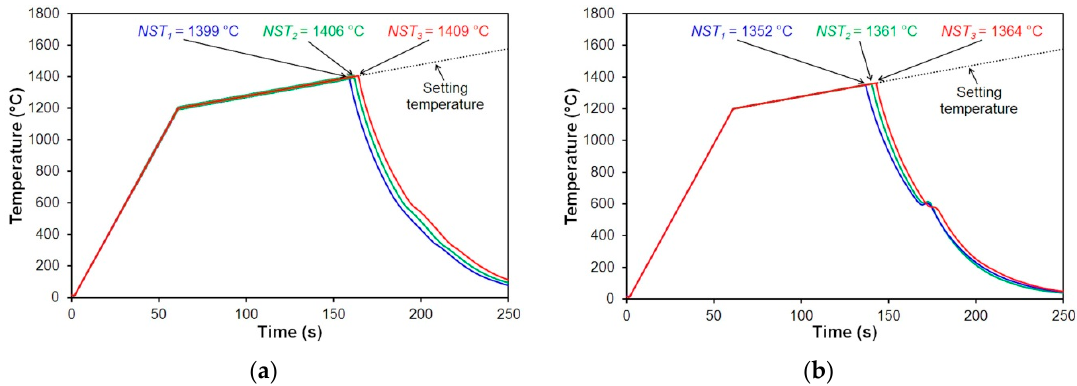
Figure 2. Graphical determination of the nil-strength temperature of the selected investigated steels: ( a ) steel E, ( b ) steel H.